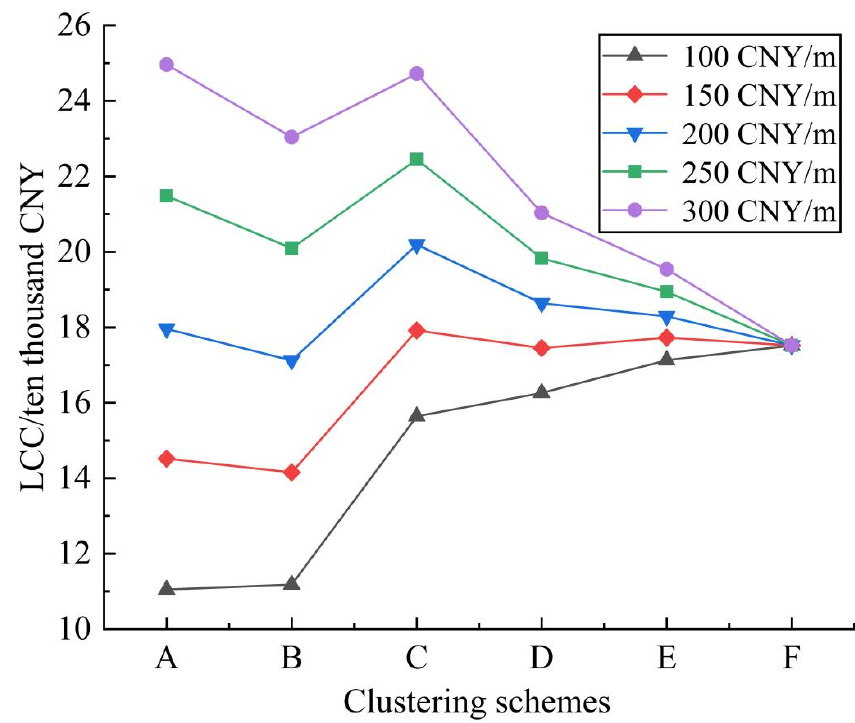
Figure 9. Variation of LCC with different clustering schemes when pipeline price changes.